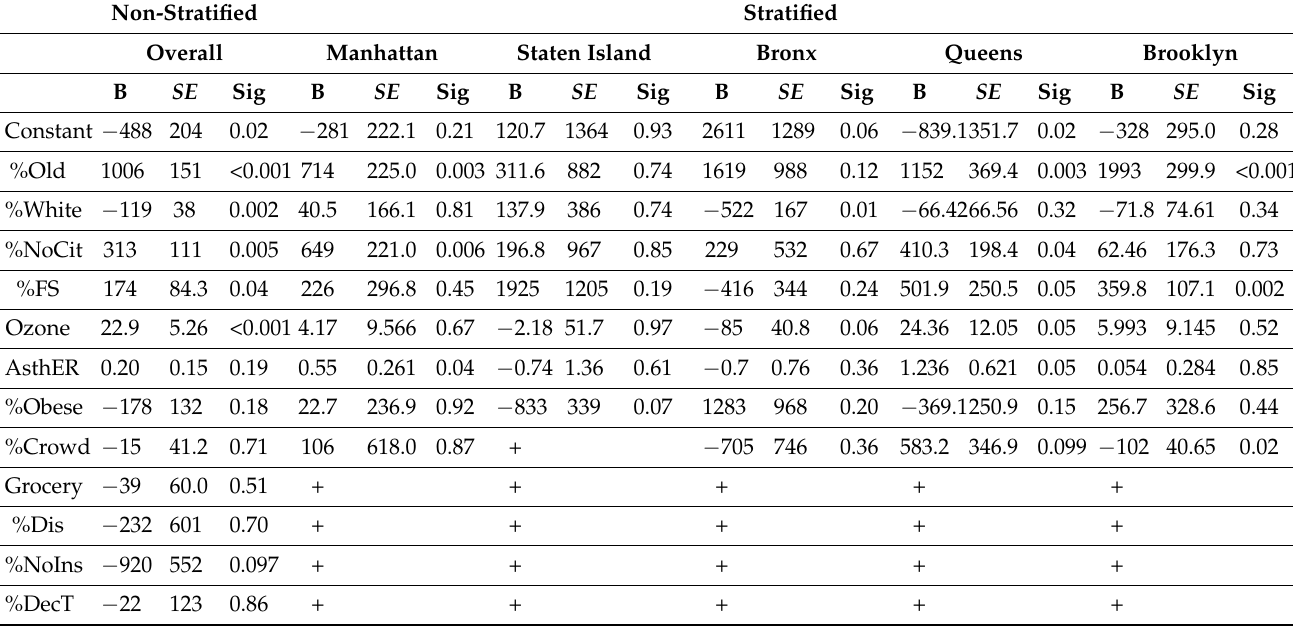
Table 6. Multiple regression of predicting New York City COVID-19 death rates per 100,000 residents, both non-stratified and